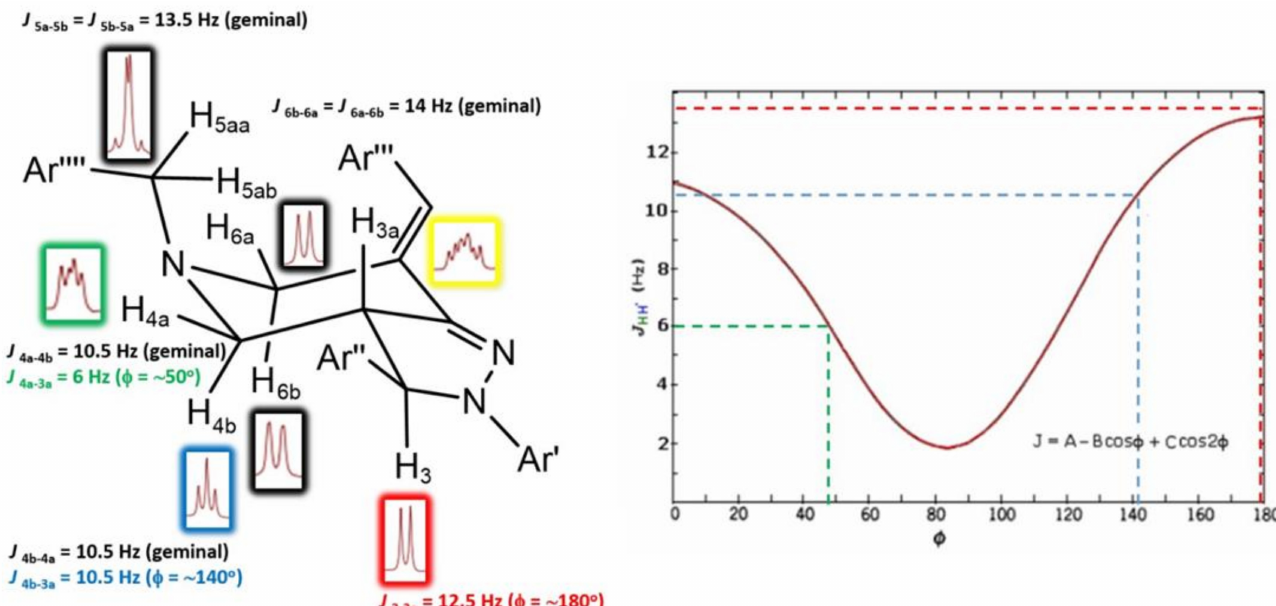
Figure 2. The orientation of aliphatic protons in the pyrazolo-pyridine ring of the title compound based on the correlation between 3 J and φ values (see Karplus Curve). The signal of proton 3a appeared as a multiplet (highlighted in yellow) because it was correlated with protons 3, 4b, and 4a. (The correlations were also confirmed by COSY and 1D-TOCSY analysis; see Supplementary Materials, Figures S9–S13.) The correlation between protons 3a and 3 is highlighted in red, the correlation between protons 3a and 4b is highlighted in blue, and the correlation between protons 3a and 4a is highlighted in green.